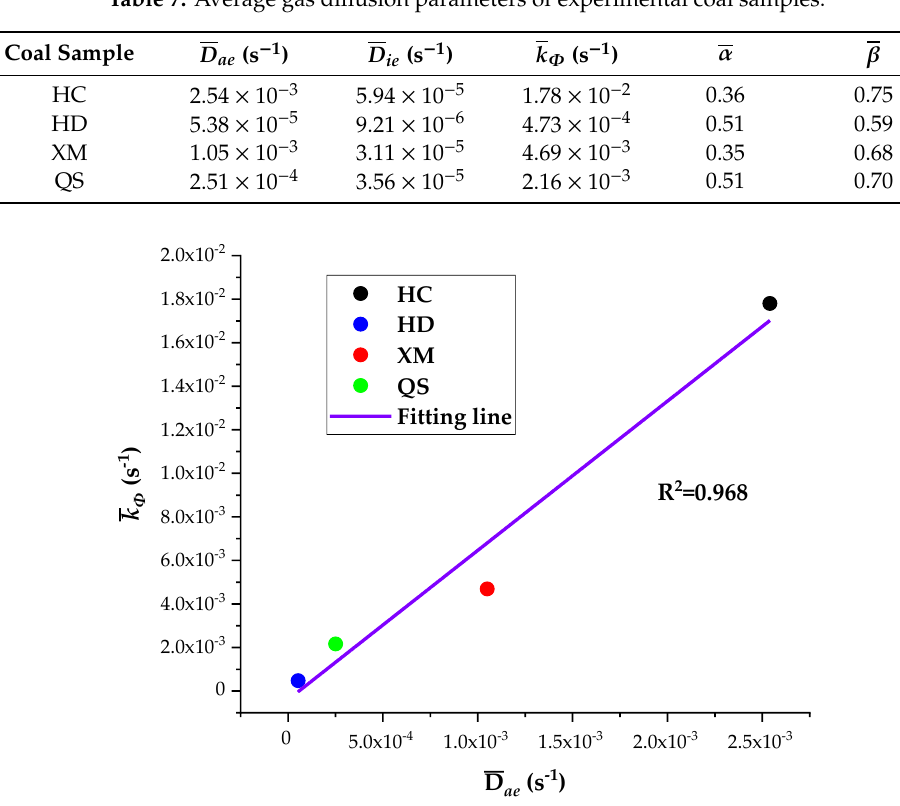
Figure 10. The linear regression of k Φ on D ae.